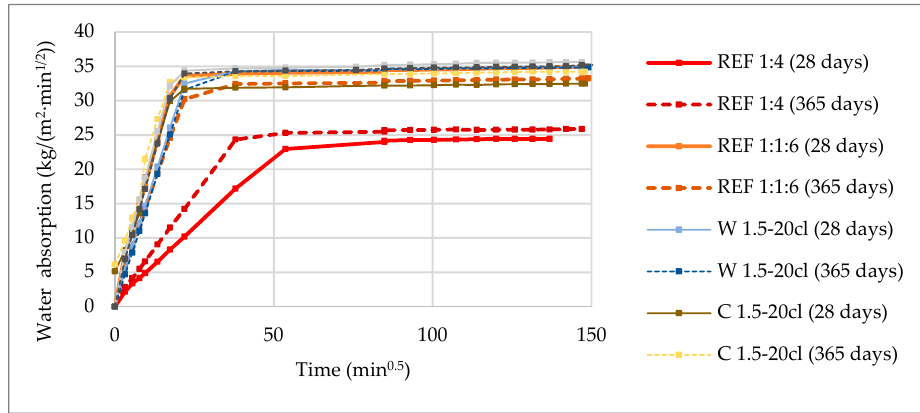
Figure 5. Water absorption by capillarity curves.